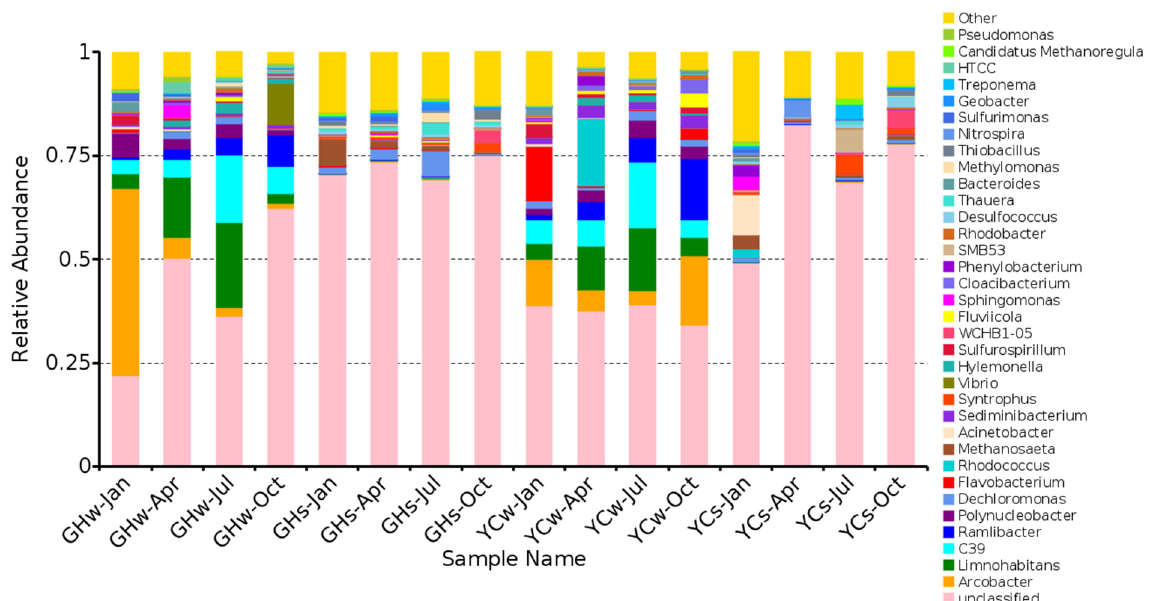
Figure 5. The relative contribution of bacterial genera associated with nitrogen metabolism.